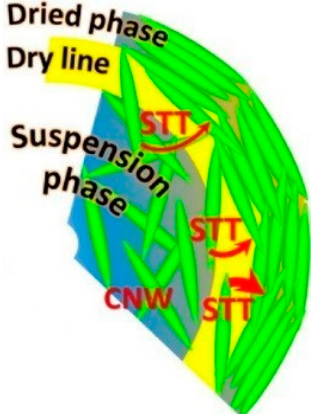
Figure 3. Illustration of the self-assembly process (Reprinted with permission from [59]. Copyright 2013, American Chemical Society.).